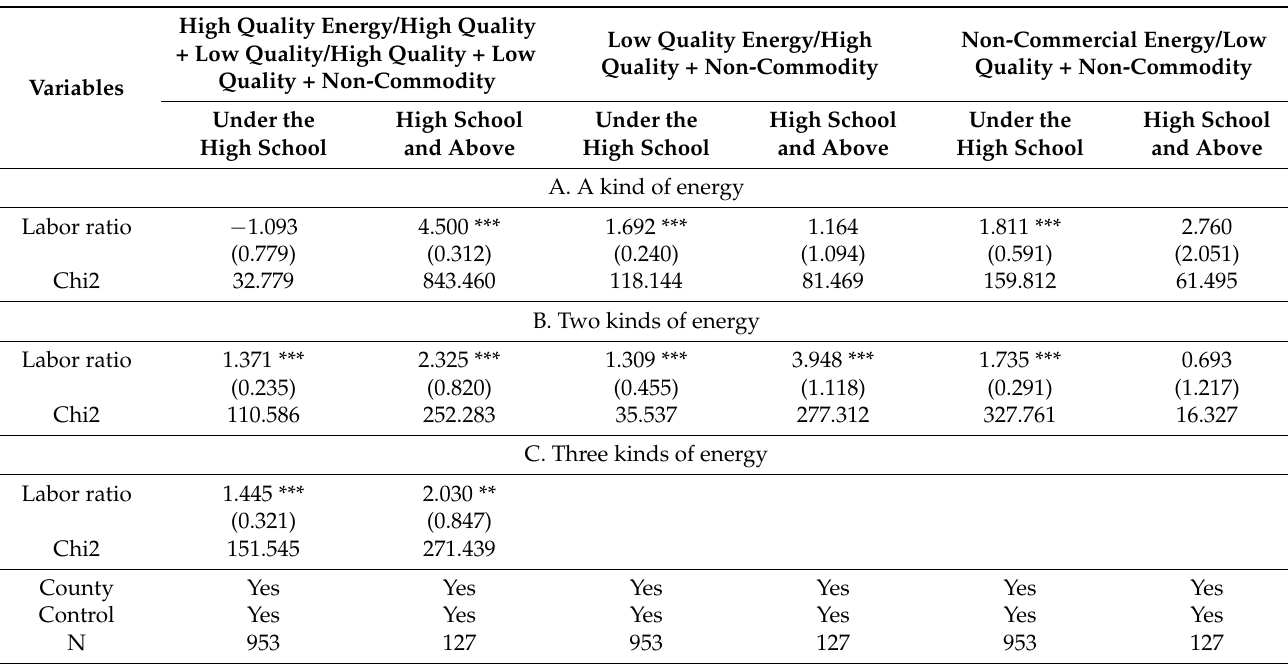
Table 3. Heterogeneity analysis results: Years of